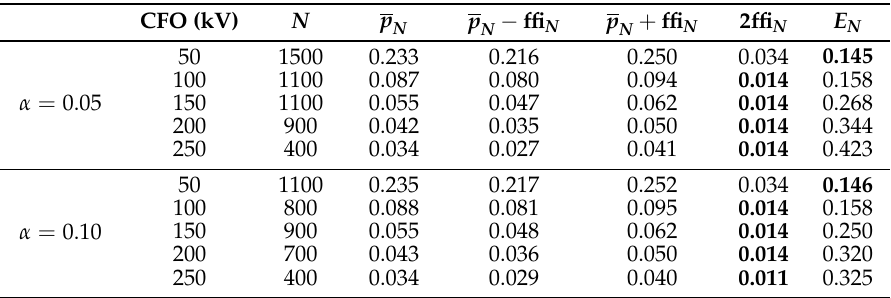
Table 2. Stopping criterion results for Test1.